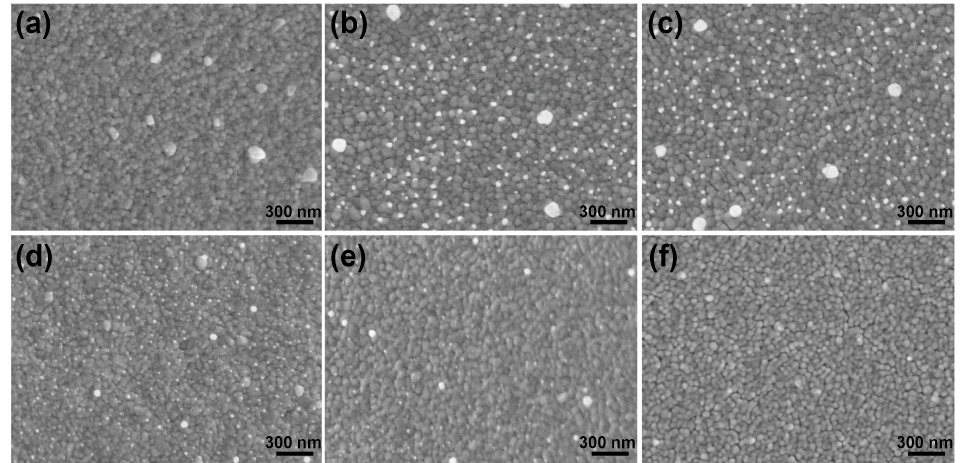
Figure 6. SEM images of Ag-coated sandpaper with different meshes. ( a ) 200; ( b ) 240; ( c ) 280; ( d ) 320; ( e ) 360; and ( f ) 400. ( e ) 360; and ( f ) 400. Biosensors 2020 , 1 , x FOR PEER REVIEW